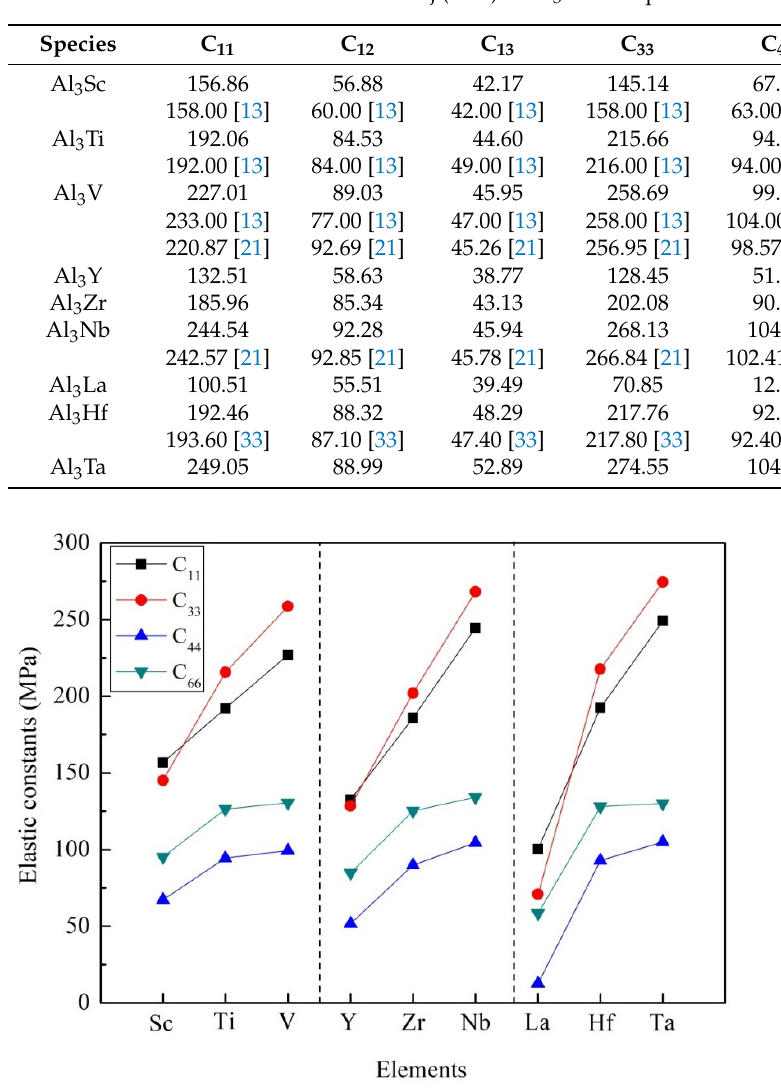
Figure 3. The trend of elastic constants of Al 3 TM compounds. On the other hand, the bulk modulus (B), shear modulus (G), Young’s modulus (E) and Poisson’s ratio ( σ ) of Al 3 TM crystal can be calculated by Viogt-Reuss-Hill (VRH) approximation method. Using the following formulas [38], the calculated values are shown in Table 3.